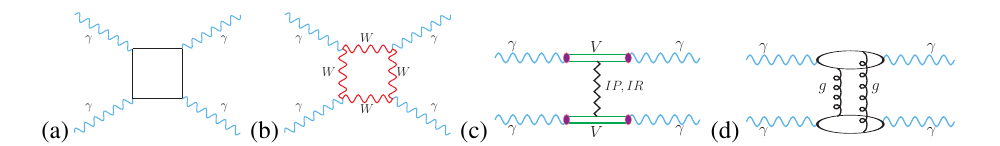
Figure 1. γγ → γγ scattering: (a) fermionic boxes, (b) one-loop W box, (c) the VDM-Regge, (d) two-gluon exchange mechanism.